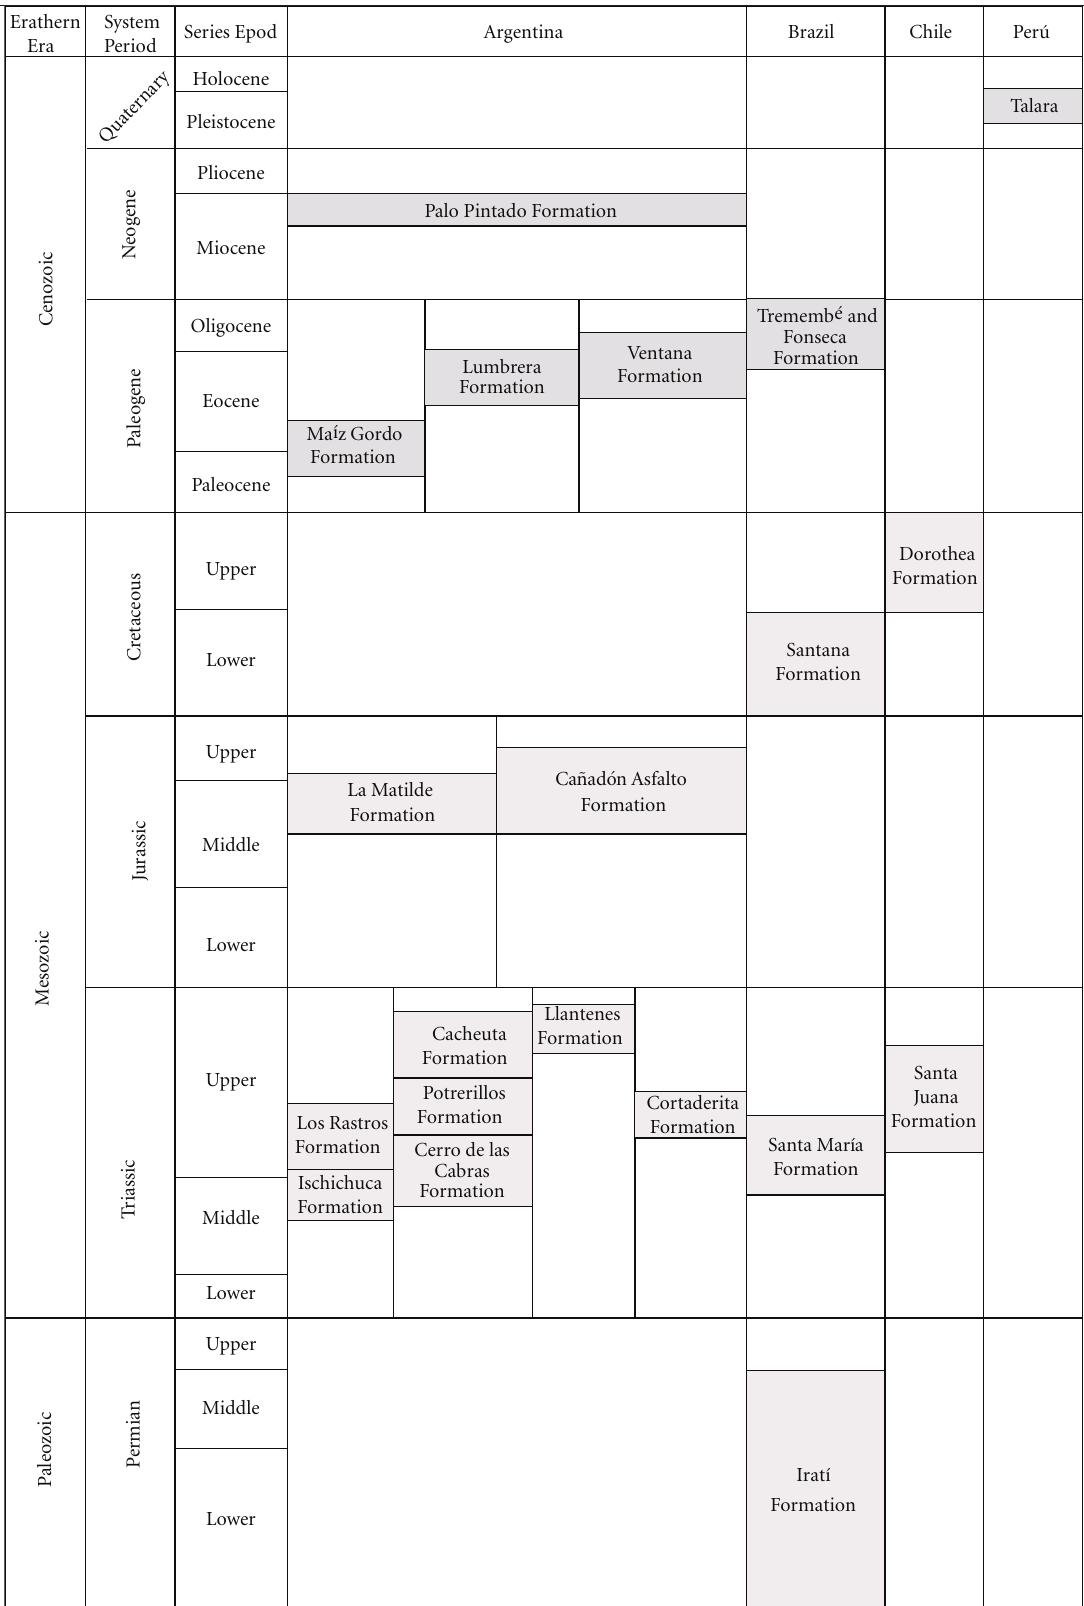
Table 3: Main stratigraphic units and beetle localities in South